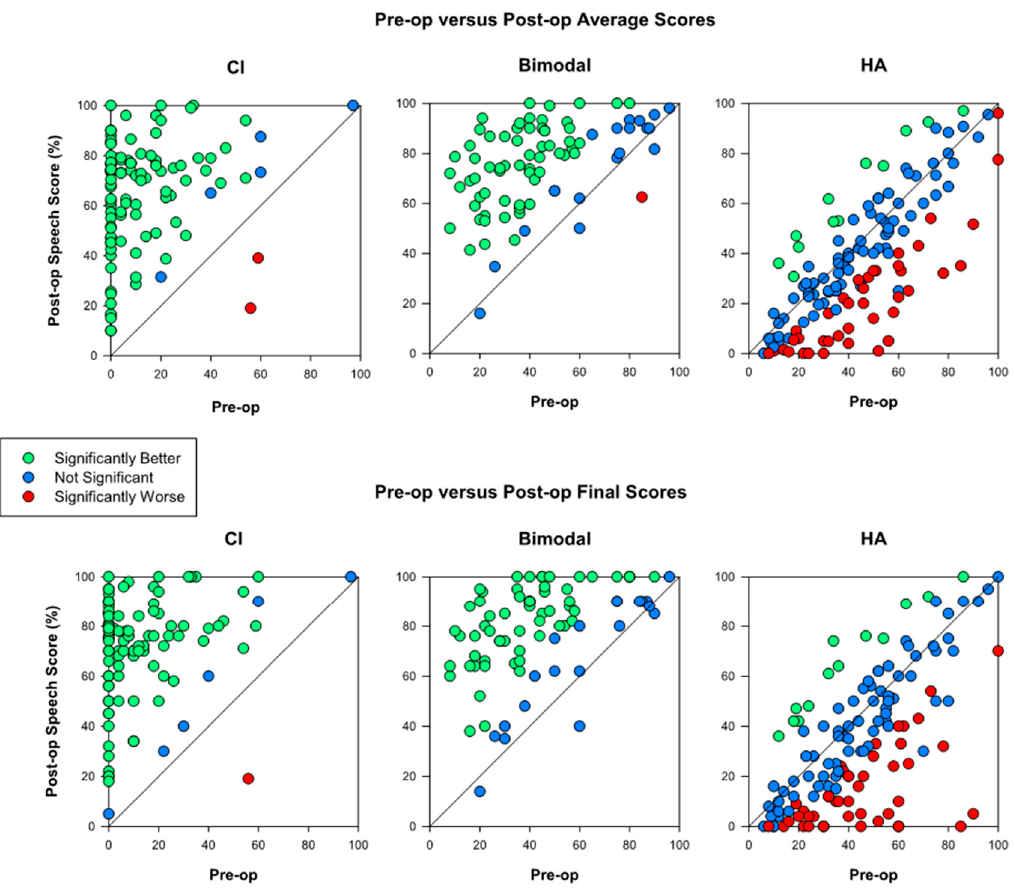
Figure 2. Postoperative vs. preoperative speech perception scores with the implanted ear only (left), both ears (bimodal condition, center), and the nonimplanted ear only (right). The top panels present average postoperative scores in the y-axis whereas the bottom panels show the latest available postoperative datapoint.